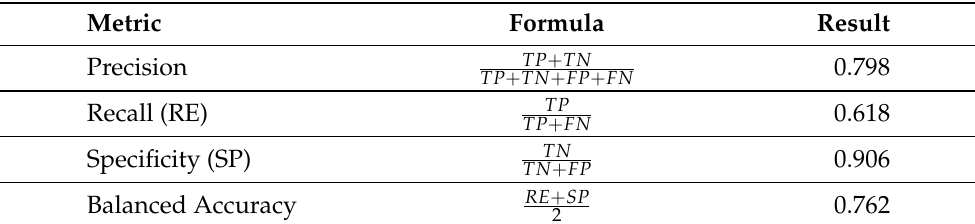
Table 2. Validation metrics for the RF cell classifier.